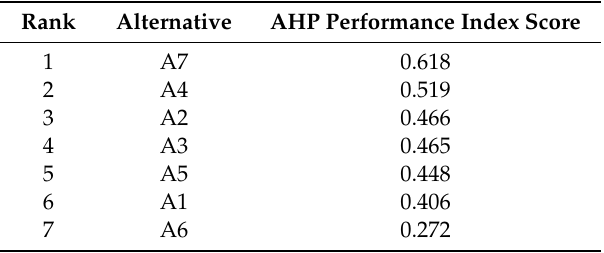
Table 5. AHP performance index score and rank when the cost weight is 0.22.